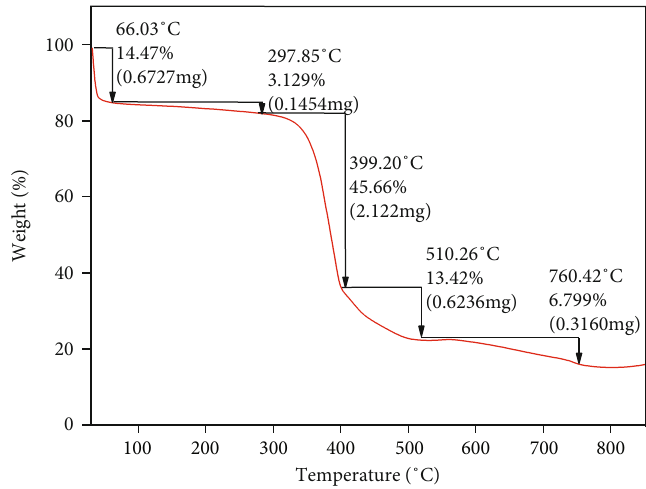
Figure 7: TGA plot of the synthesized Zn-adeninate bio-MOF.